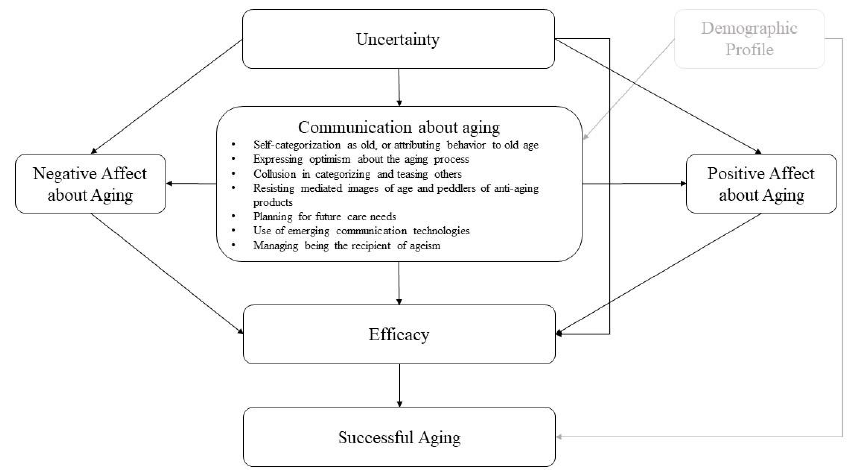
Figure 1. The original of the communication ecology model of successful aging (CEMSA) [37].